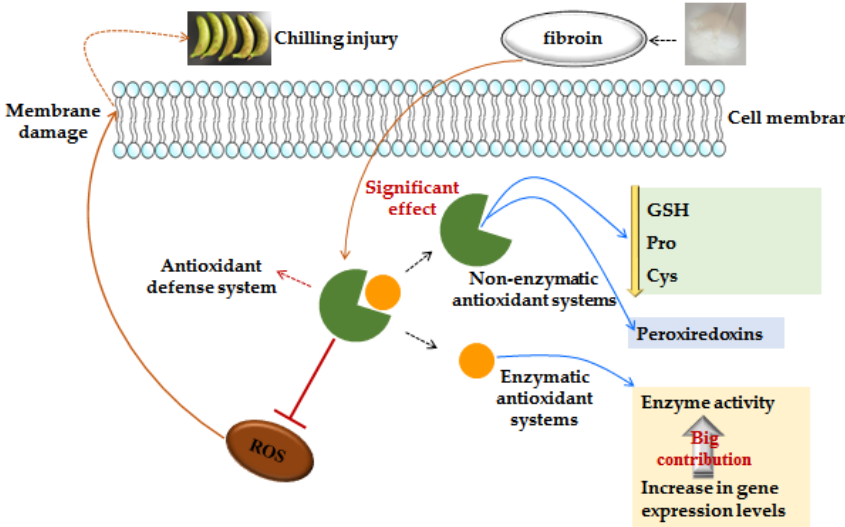
Figure 7. The possible mechanism of peel browning inhibition via enhanced antioxidant capability of harvested banana peel by fibroin treatment.